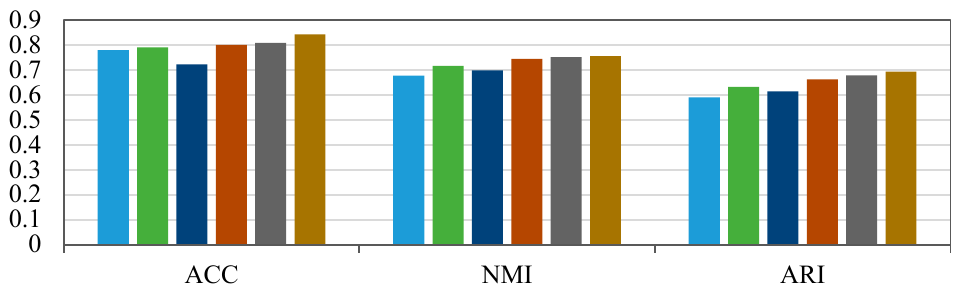
Figure 8. Performance comparison of Amazon-Fashion clustering.